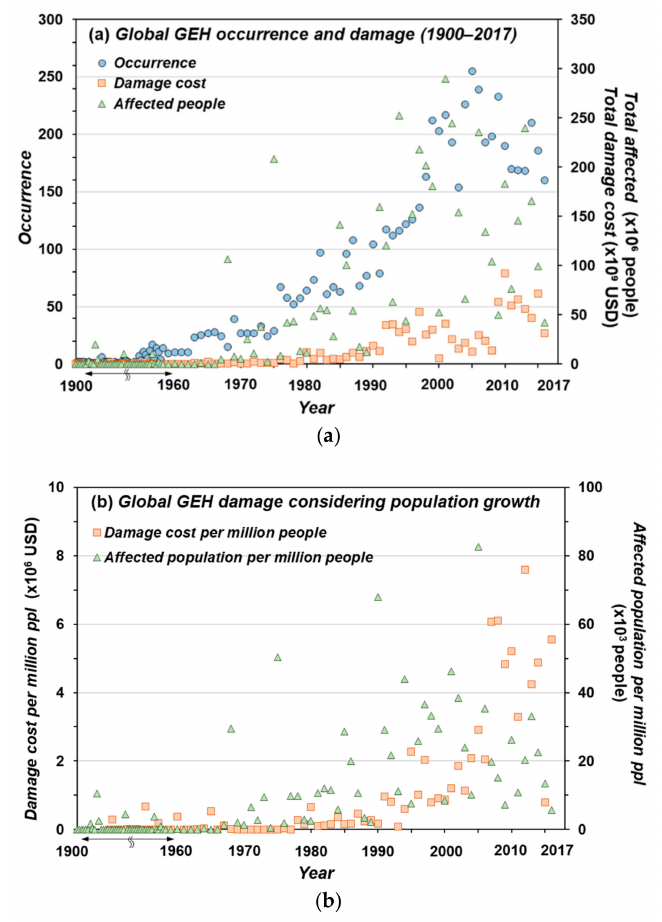
Figure 6. Global geotechnical engineering hazard status (1900–2017): ( a ) Occurrence and total damage indices; ( b ) Damage cost and a ff ected population per million people. Reproduced with permission from the Centre for Research on the Epidemiology of Disasters (CRED), Emergency Events Database (EM-DAT); published by the Universit é catholique de Louvain (UCL)